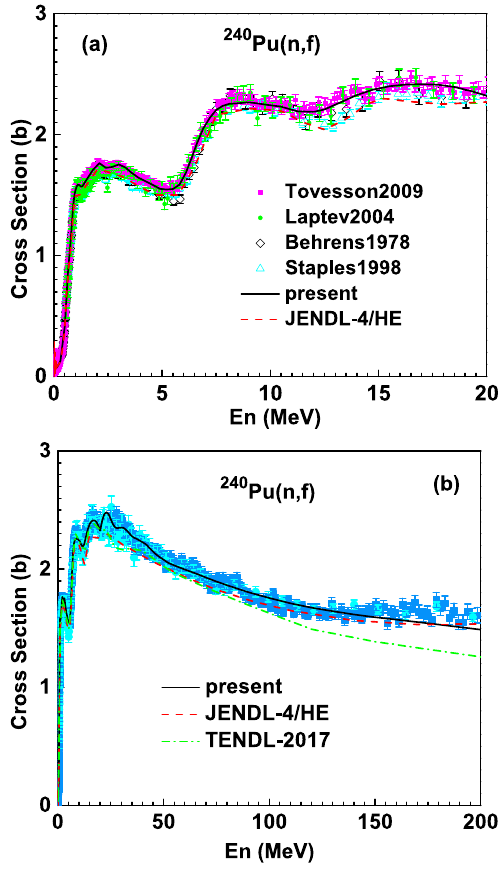
Figure 3. Calculated result of fission cross section (solid lines) for n + 240 Pu reaction compared with the experimental data and the evaluated data from JENDL-4 / HE (dashed lines) and TENDL (dash-dotted line). (a) at incident energies below 20 MeV, (b) at incident energies below 200